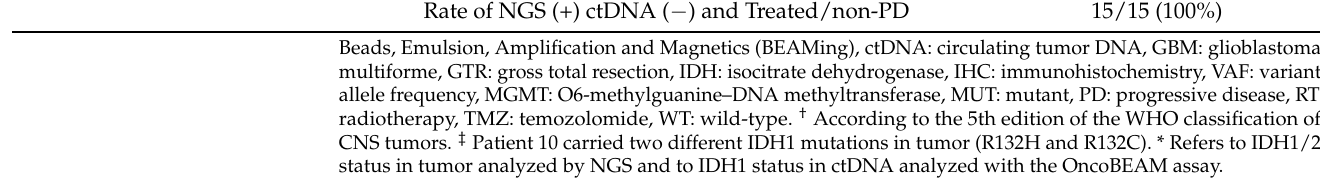
Table 1. Cont. Variable Value Pts with concordance NGS ( − ) and ctDNA 4/4 (100%) ctDNA (+) rate in NGS (+) pts (true-positive rate) 3/21 (14.3%) ctDNA ( − ) rate in NGS (+) pts (false-negative rate) 18/21 (86.4%) Rate of NGS (+) ctDNA (+) and Untreated/PD 3/6 (50%) Rate of NGS (+) ctDNA ( − ) and Treated/non-PD 15/15